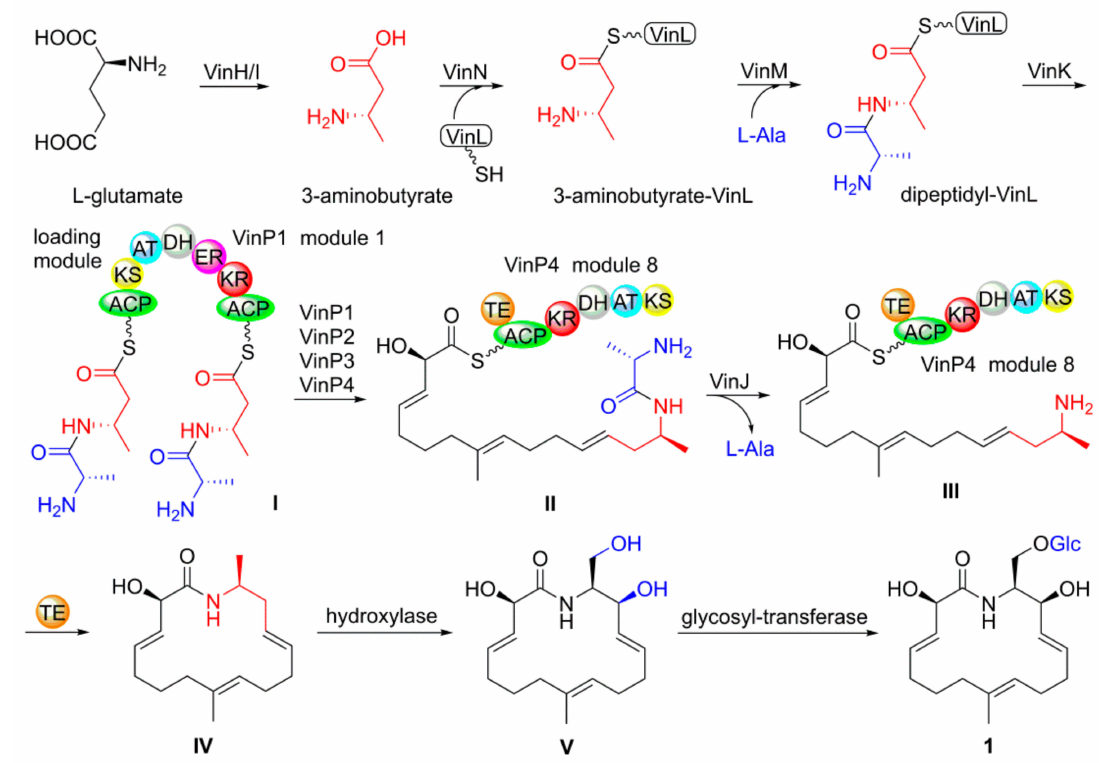
Figure 5. Proposed biosynthesis pathway of 1 .